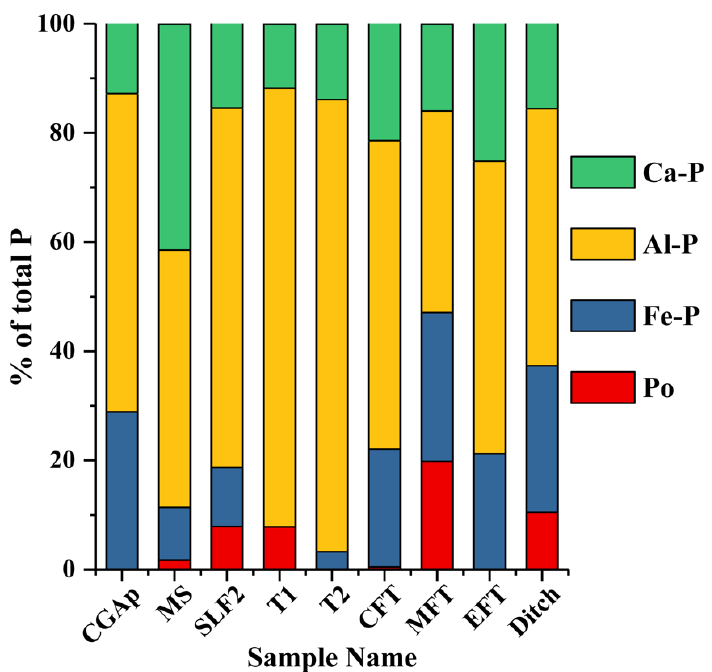
Figure 5. Graphical representation of the linear combination fitting of the soils with phytic acid P (Po), P adsorbed to ferrihydrite (Fe-P), P adsorbed to amorphous aluminum hydroxides (Al-P), and hydroxyapatite (Ca-P). CGAp is a community garden soil; MS had a manure storage shed on it; SLF2 is an agricultural field on the same farm as MS; T1 and T2 are agricultural fields from a second farm; and CFT (center field transect), MFT (middle field transect), EFT (edge field transect), and Ditch are agricultural soil samples from a third farm along a transect.